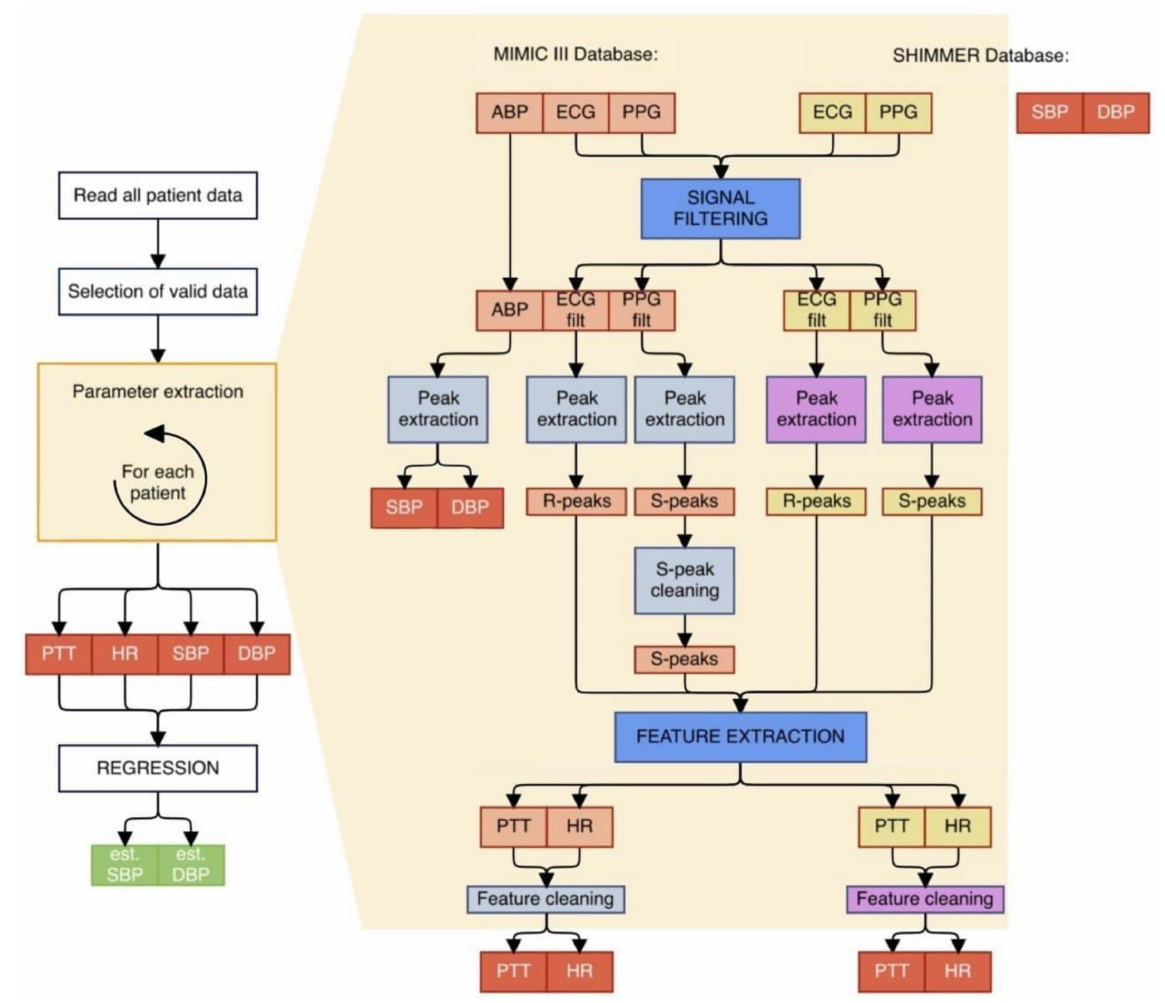
Figure 15. Algorithm